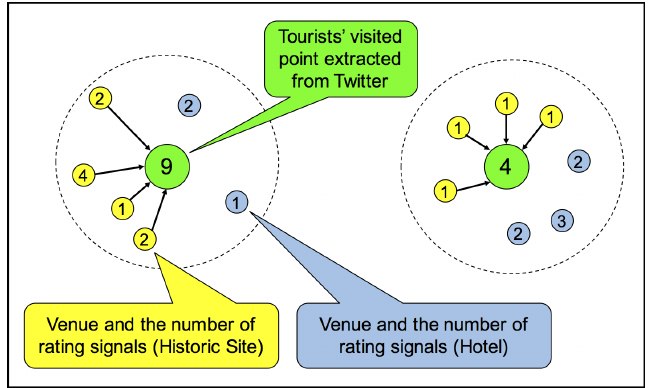
Figure 8. Characterization procedure: Each point’s characteristics are defined by the total number of rating signals.